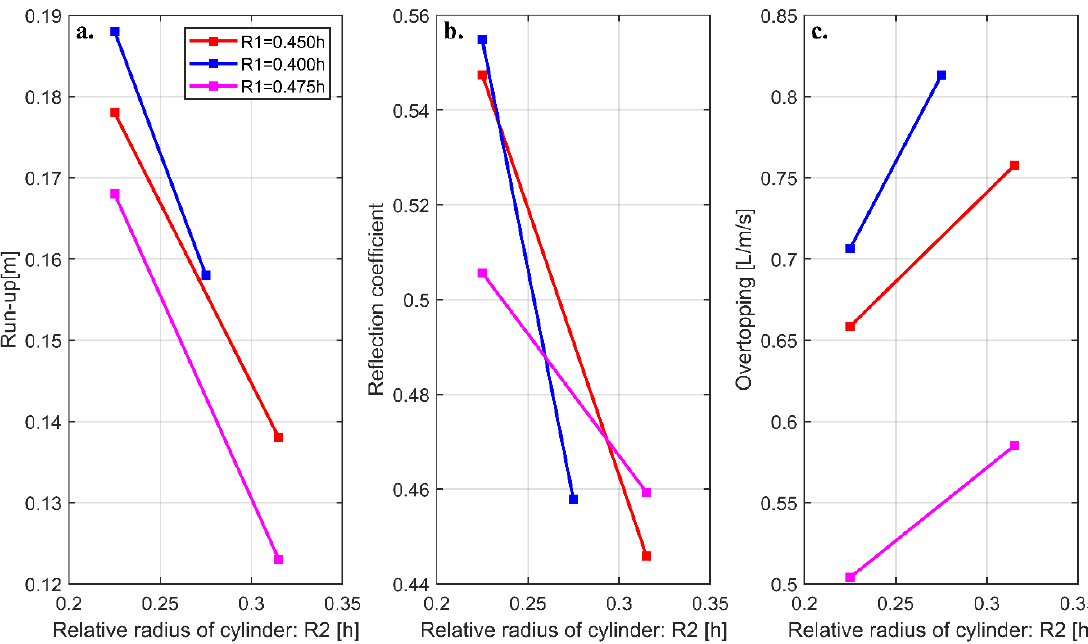
Figure 6. Numerical results of wave performance in the relative wave run-up ( a ), reflection coefficient ( b ), and overtopping ( c ) under various R1 (relative radius of the sphere) and R2 (relative radius of the cylinder), as stated in Figure 1 and Table 2.